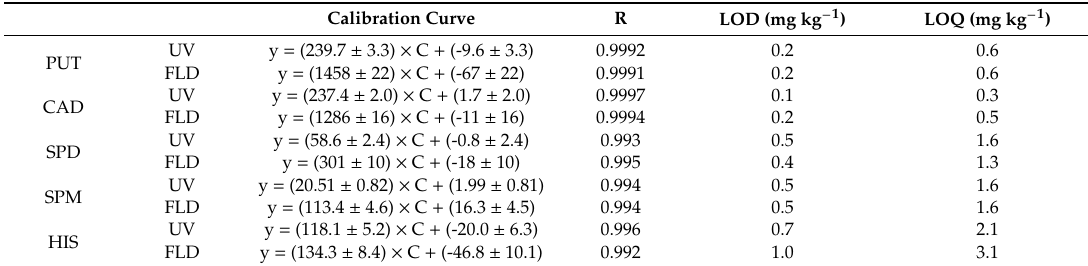
Table 4. Matrix matched calibration curves of sea bass sample, limit of detection (LOD) and quantification (LOQ) of the BAs with UV and Fluorescence detectors C: µ g mL − 1 . y: analyte peak area. BAs concentration range: 0.2–32 mg kg − 1 sample, which corresponds to 0.05–8.0 µ g mL − 1 measured